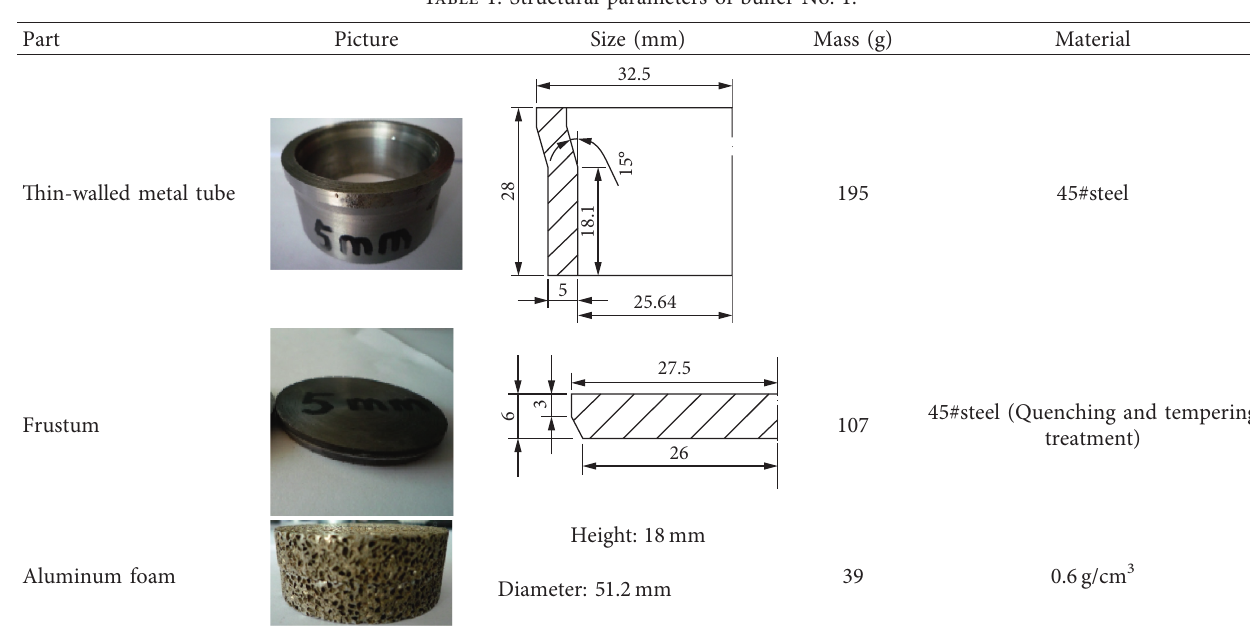
Figure 8: Physical drawing of buffer No. 1. Table 1: Structural parameters of buffer No.